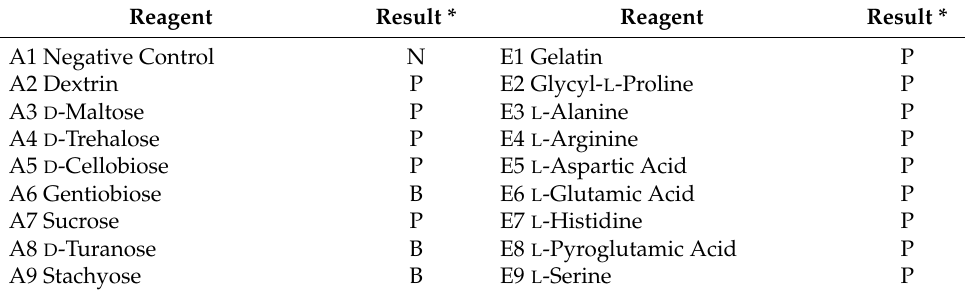
Figure 2. Colonial morphology, Gram staining and scanning electron microscopy image of the Table 2. Results of Biolog identification of strain isolate WH21406. ( A ) Colonial morphology of WH21406, ( B ) Gram staining image of WH21406, ( C ) Scanning electron microscopy image of WH21406. Table 2. Results of Biolog identification of strain WH21406.